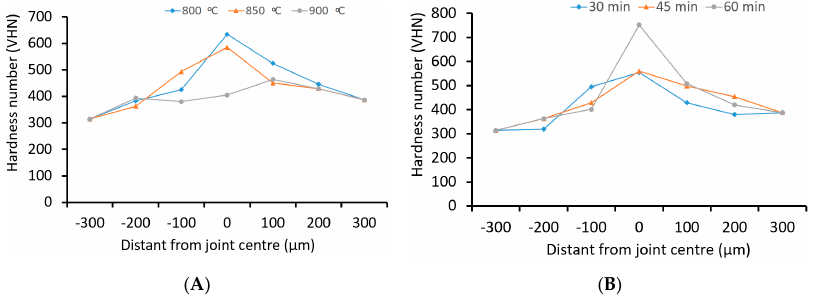
Figure 12. ( A ) Hardness measurements for the sample bonded for 30 min as a function of bonding temperature; ( B ) Hardness measurements for the sample bonded at 850 °C as a function of bonding time.